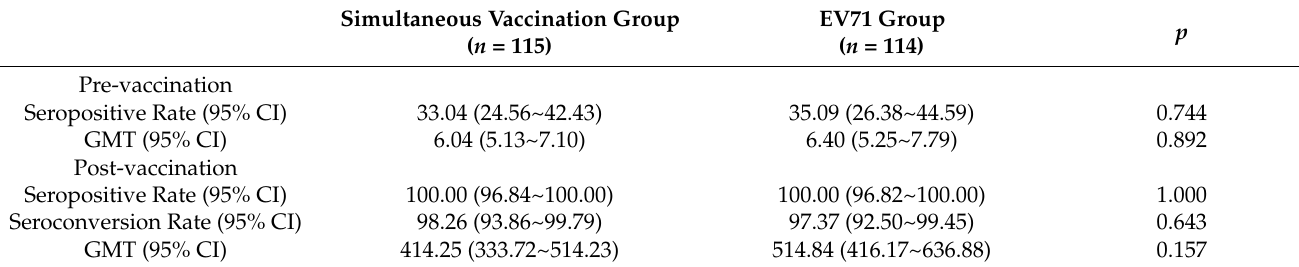
Table 2. Antibody responses to EV71 in the per-protocol